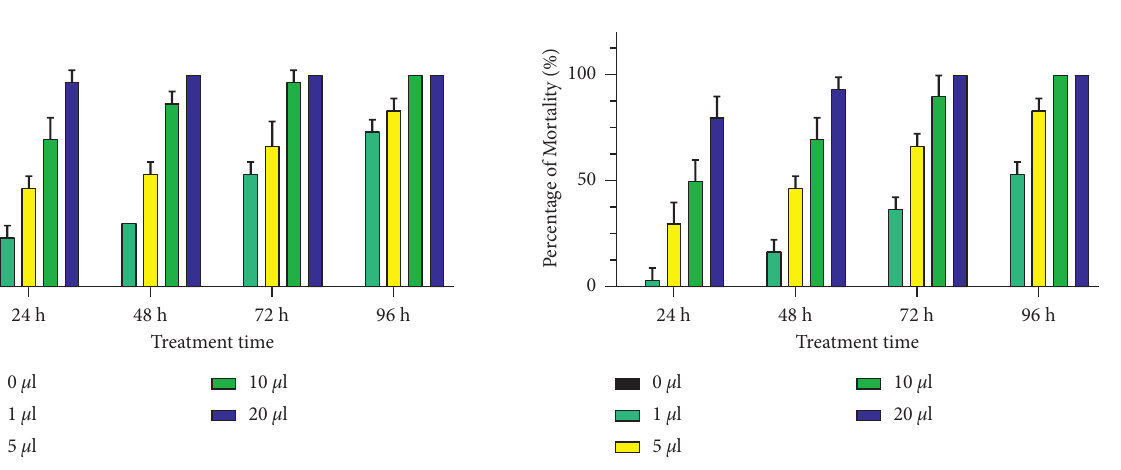
Figure 10: Mortality rate of Callosobruchus maculatus Fab. adults exposed to a contact test of Matricaria recutita L. essential